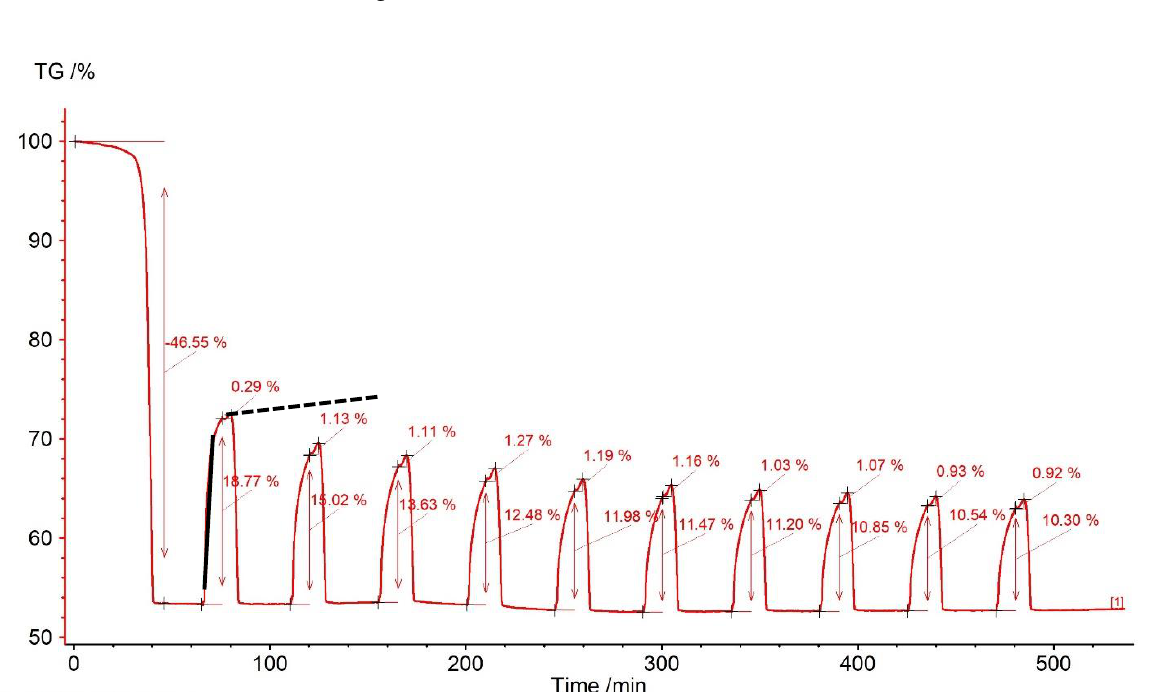
Figure 4. TGA and DSC curves for dolomite.